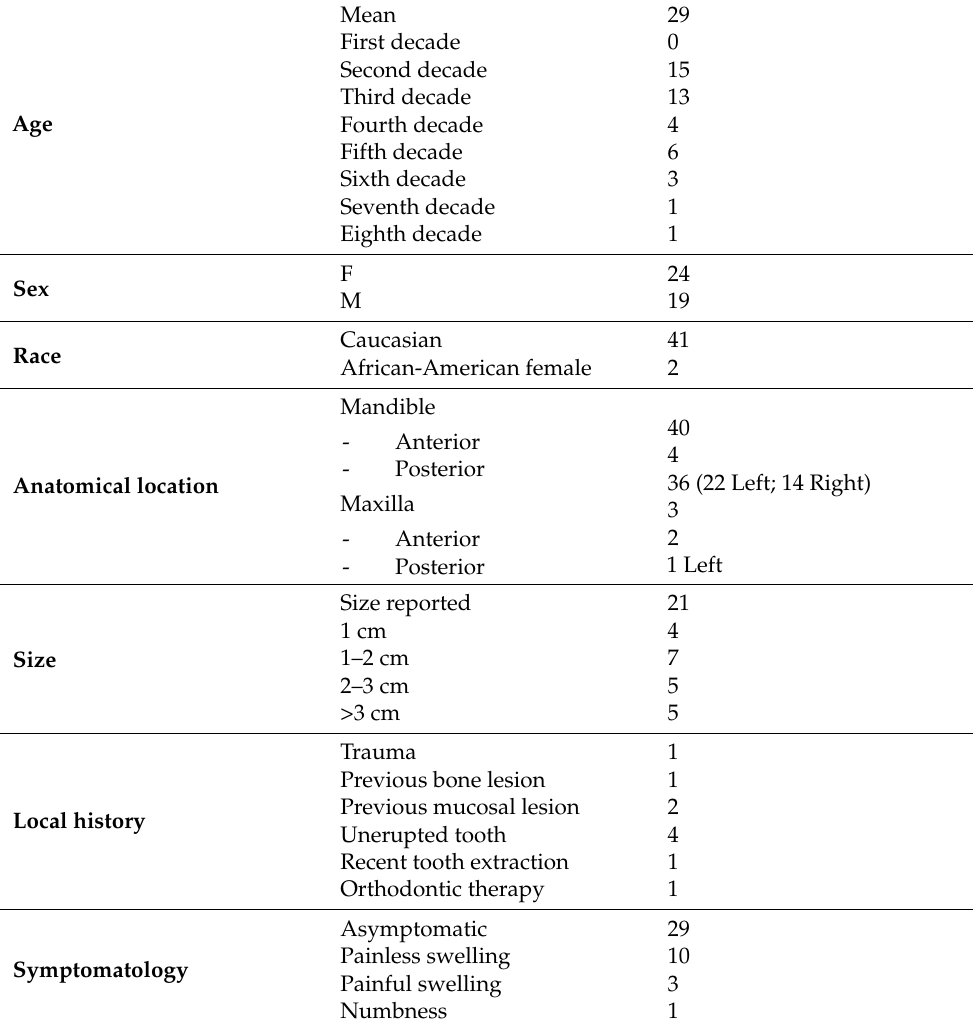
Table 1. Demographic data, clinic radiographic, and histological features of the cases retrieved in the literature